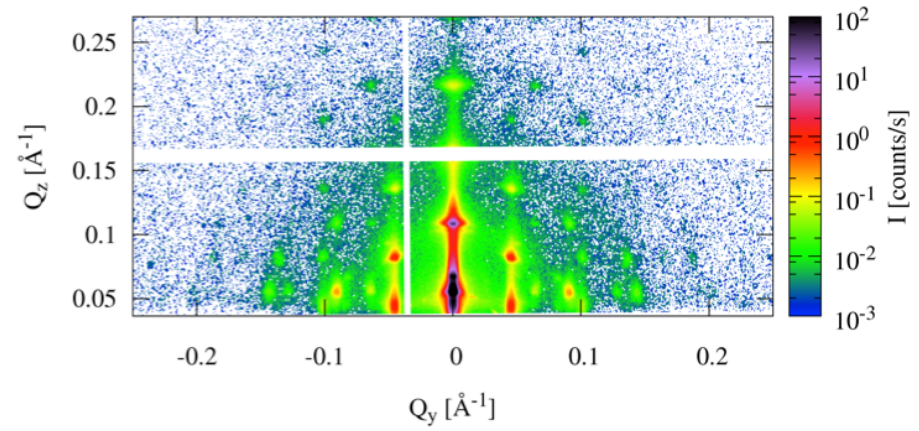
Figure 3: GISAXS measurement from an assembly of magnetic nanoparticles of cubic shape deposited on a substrate. From the positions of the peaks, one can deduce a body centred tetragonal ordering between nanoparticles. (Courtesy of E. Josten, Helmholtz-Zentrum Dresden-Rossendorf)